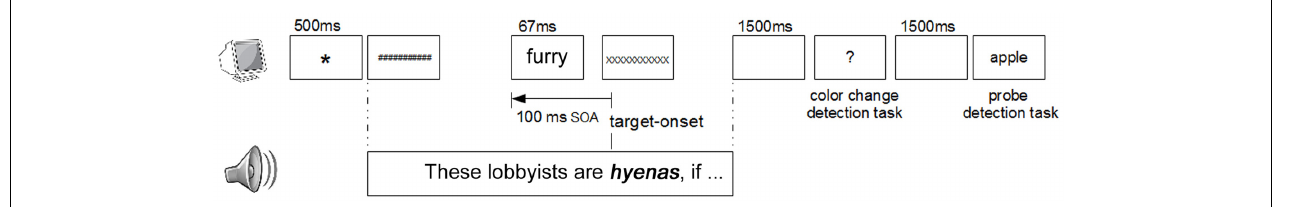
FIGURE 2 | Cross-modal masked priming procedure. Schematic illustration of the priming procedure in sentential